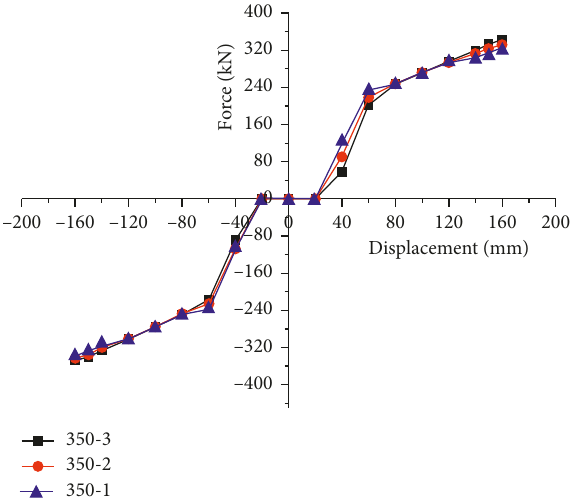
Figure 12: Skeleton curve of the